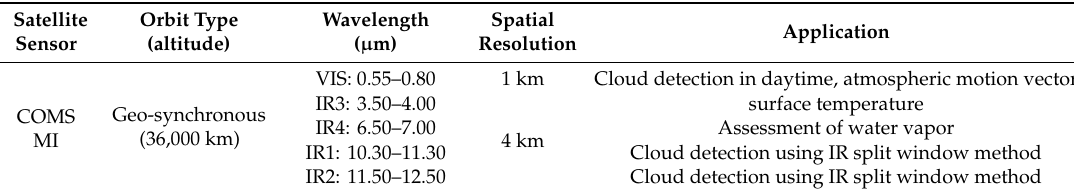
Table 1. Detailed characteristics of Communication, Ocean, and Meteorological Satellite (COMS) Meteorological Imager (MI) used to estimate solar radiation in the study